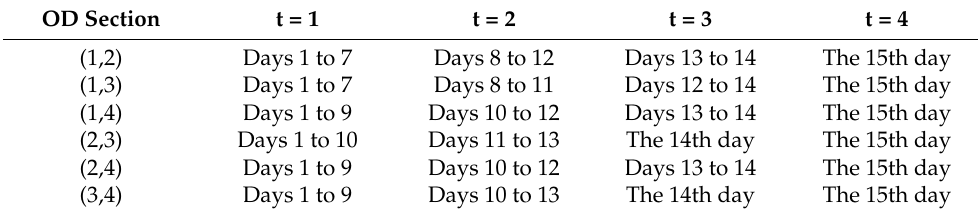
Figure 7. Ticket- purchasing requests’ distribution. Figure 7. Ticket-purchasing requests’ distribution. Table 6. Time division table of pre-sale period for each OD